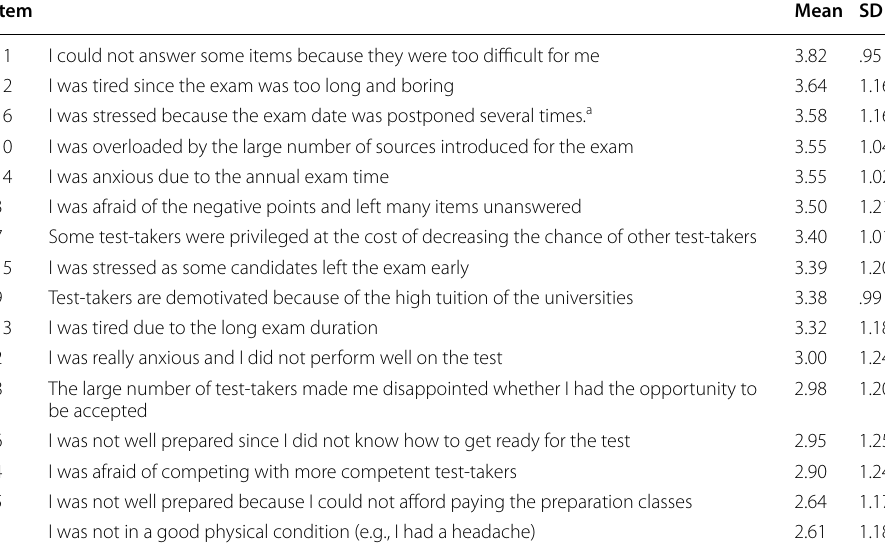
Table 7 Items corresponding to the effect of test-takers